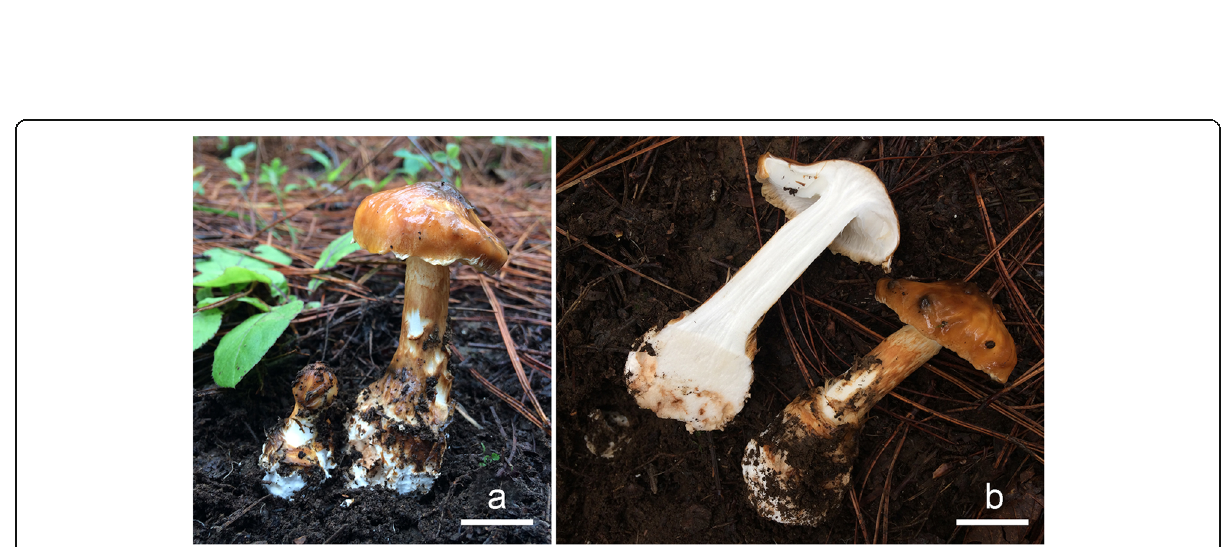
Fig. 11 a – b Basidiomes of Squamanita sororcula (HKAS107306A, holotype). Photos by Fa Li. Bars: 20